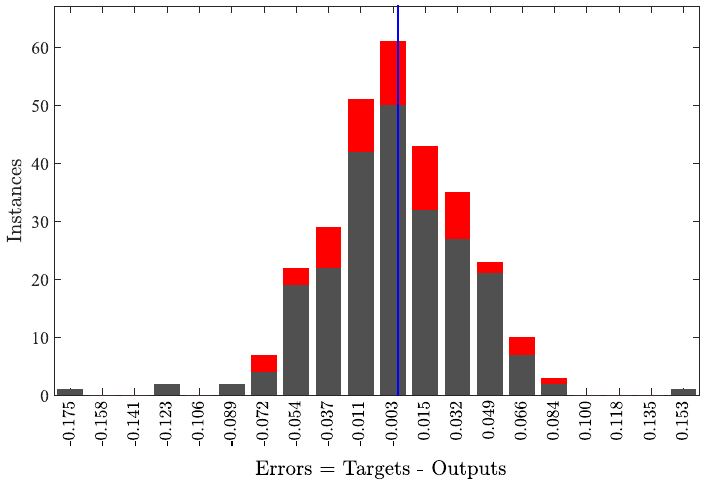
Figure 6. Error histogram of A m with 20 bins. The red part denotes test data and the grey part denotes training